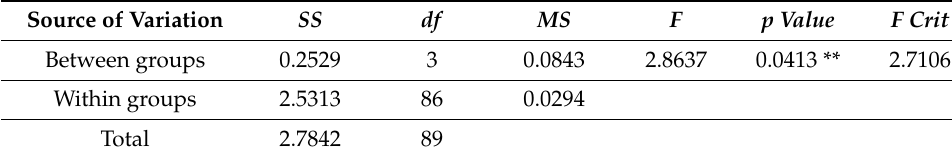
Figure 7. Box and whisker plot of bootstrap efficiency by groups. Table 7. ANOVA results of bootstrap DEA scores by groups.